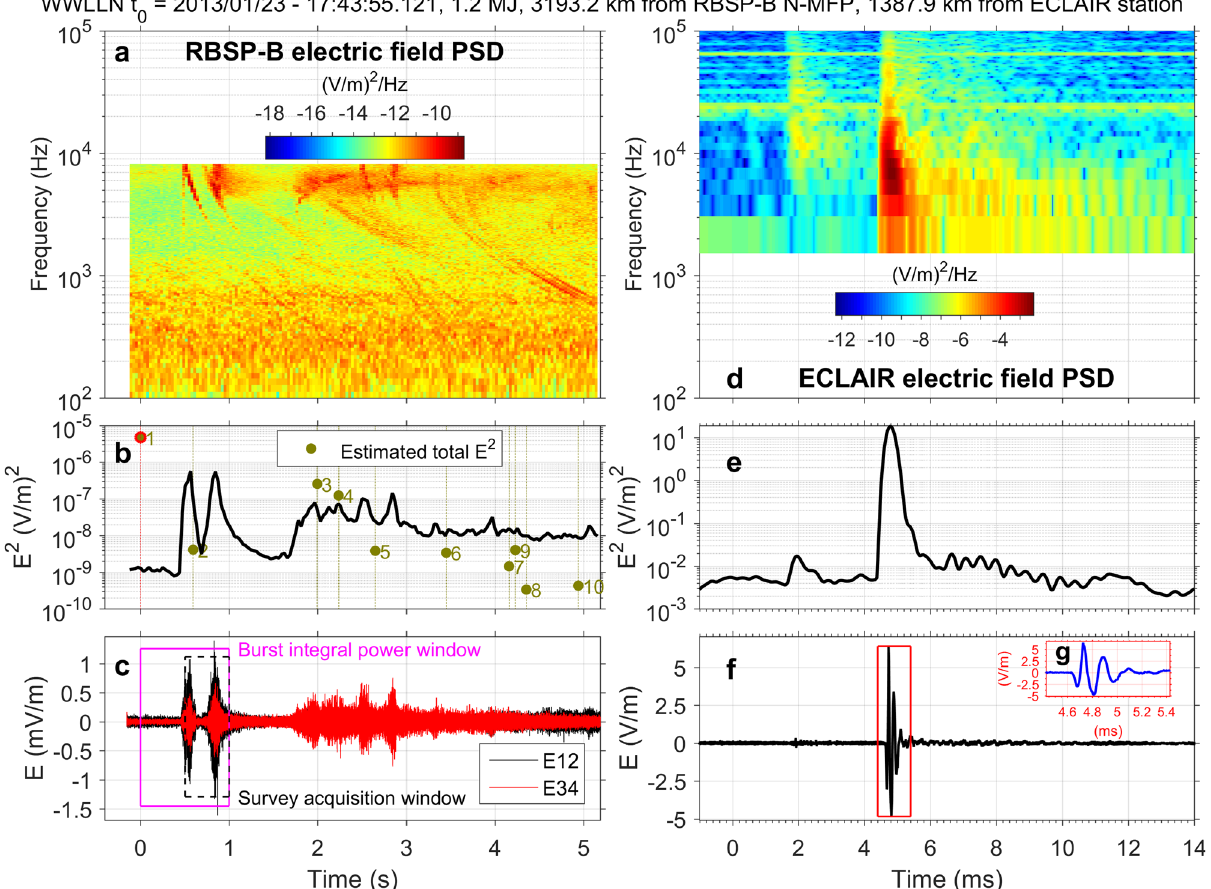
Fig. 3 Simultaneous space and ground measurements of a superbolt. (Left) Space and (right) ground simultaneous measurements of a superbolt (1.2 MJ) detected by WWLLN with t = 0 at 2013/01/23-17.43.55.121 UTC. In space, we display the Van Allen Probes (RBSP) burst-mode measurements versus time of a the electric fi eld power spectral density (PSD in V 2 /m 2 /Hz) measured by EFW, b the evolution of the squared electric fi eld (intensity) and estimated time at the satellite of all WWLLN-detected lightning strokes in the time window (dashed vertical lines), and c the satellite-detected waveform with the survey acquisition and burst integration windows. (right) On the ground, we display (with same units) the evolution of d the electric fi eld PSD in V 2 /m 2 /Hz and of e the squared electric fi eld, f the electrical fi eld waveform and g its zoom. The electric fi eld PSD ( a ) has a characteristic descending tone shape in space (between t ~ 0.4 – 0.6 s) but shows a second wave (starting at t ~ 0.6 s) that is the bounce re fl ection of the primary wave. The sharp rising tone just prior to the descending tone shape (for frequencies within 2 × 10 2 and 9 × 10 3 Hz) is an anti-aliasing fi lter effect with a fold over of the power above the top frequency that should be disregarded. The estimated median squared electric fi eld (in mV 2 /m 2 ) (following 22 ) of all other lightning is reported in b with green circles (#2 – #10) and are found to be much lower than the superbolt ’ s intensity and its estimate (#1 green circle with a red contour) (more detail in Supplementary Table 4). The superbolt frequency decreases below 400 Hz (deep in the whistler-mode hiss wave band) after 2 s ( a ). See Supplementary Fig. 6 for more detail on space measurements and Supplementary Fig. 7 for more detail on ground-based fi nd a change of sign between these two waves, which indicates the second wave reaches the spacecraft from the opposite side of the fi eld line. In the absence of any other event attested by WWLLN and since the time delay is consistent with one re fl ec- tion, this suggests the two superbolt ’ s waves have entered the magnetosphere at different latitudes surrounding the source, followed then different paths, with one wave reaching fi rst the spacecraft and the second reaching the spacecraft 0.2 s later after bouncing at the conjugate point of the fi eld line. This is one of the plausible and classic scenarios obtained from ray-tracing simulations 24 . The peak squared electric fi eld measured by an ECLAIR ground station for this event is 20 (V/m) 2 1387 km (3e) from the source. The average squared electric fi eld over its duration (1.5 ms) is 4 (V/m) 2 , about 400 times greater than cloud-to-ground lightning measured on the ground (cf. discus- sion below). Quantifying the power spectral density on the larger than for normal lightning 21 . However, this is not as large as some of the superbolts we discuss next. ground is critical for validating ray-tracing simulations that